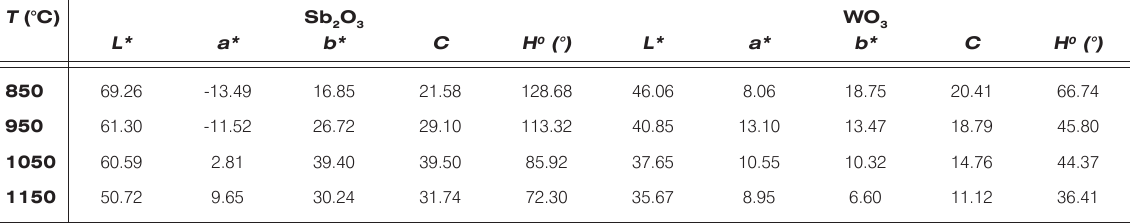
Cr M O (x = 0.4 0.2 0.4 2